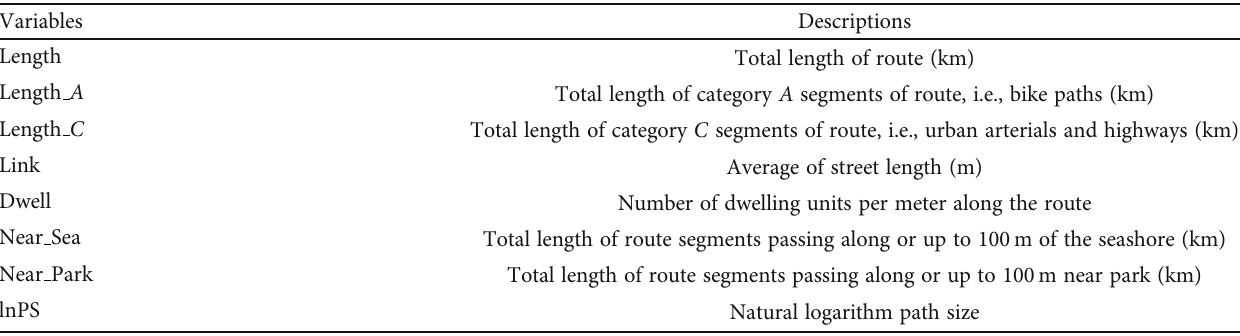
Table 3: Descriptions of the explanatory variables.